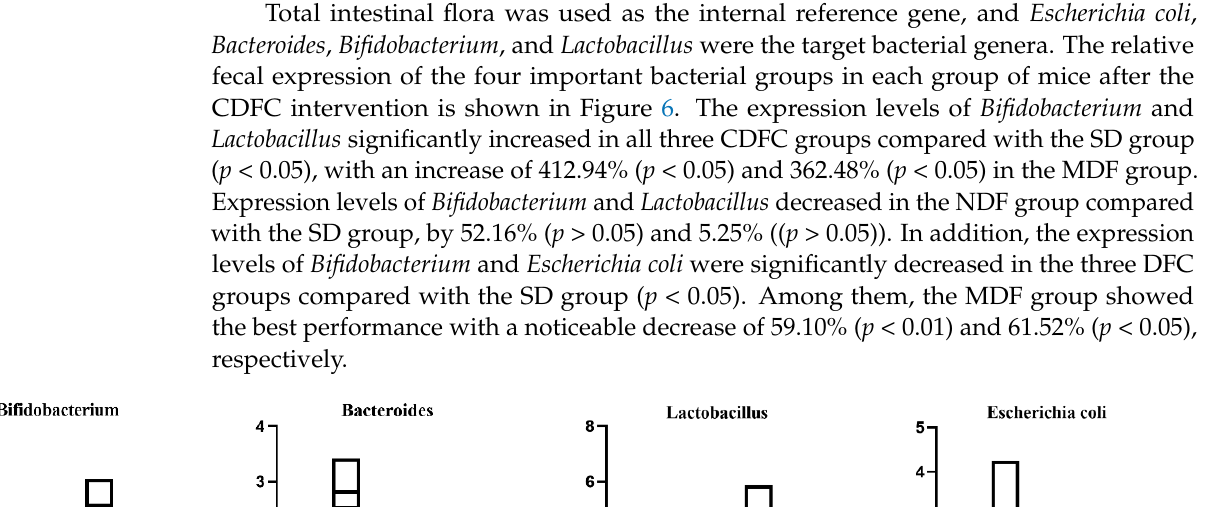
Figure 5. Representative images of HE staining in the brain (magnification, 400×); red arrows indi- cate normal cells, blue arrows indicate crinkled cells.